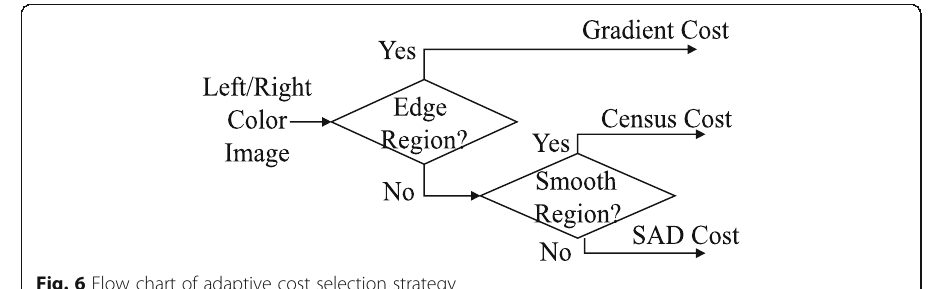
Fig. 6 Flow chart of adaptive cost selection strategy